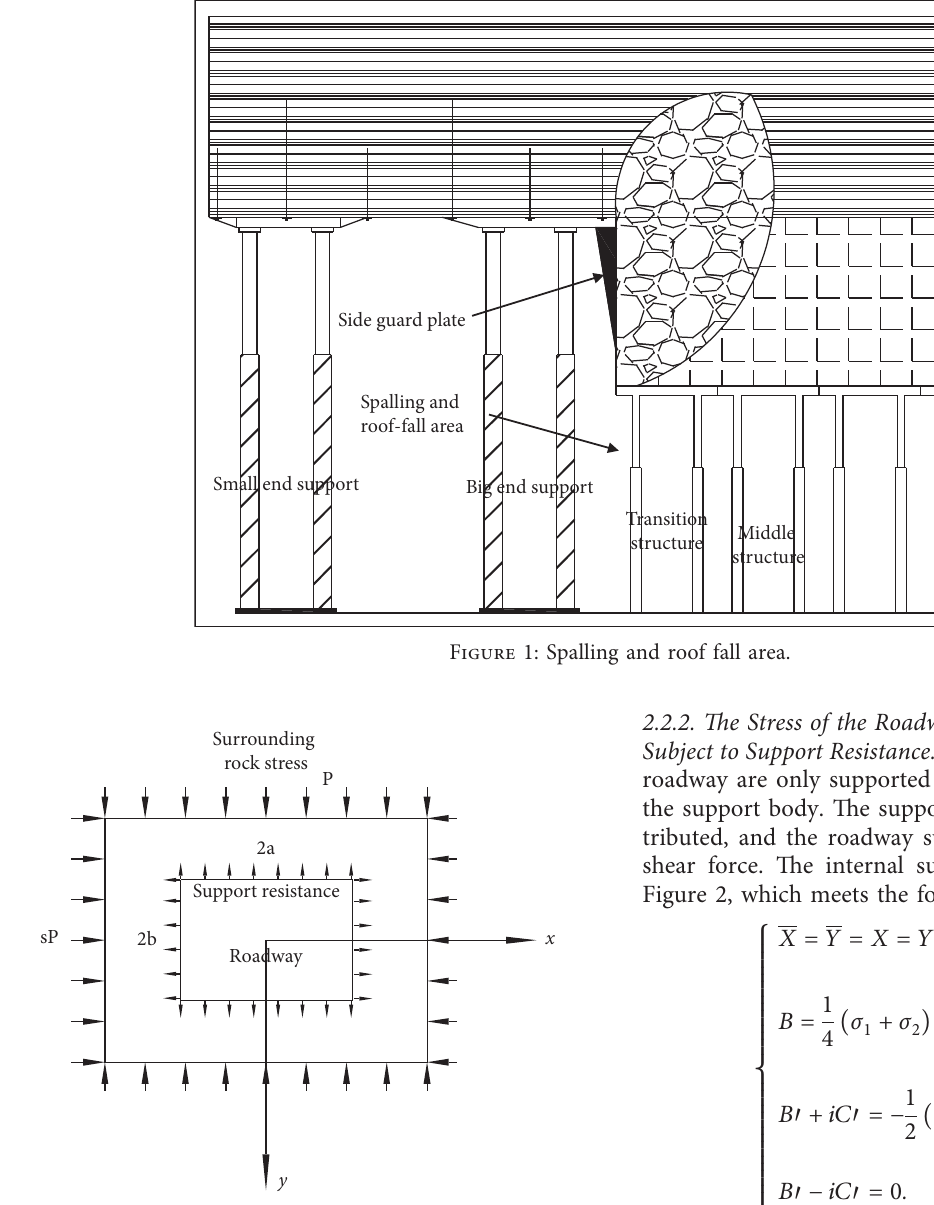
Figure 2: The mechanical model of rectangular roadway